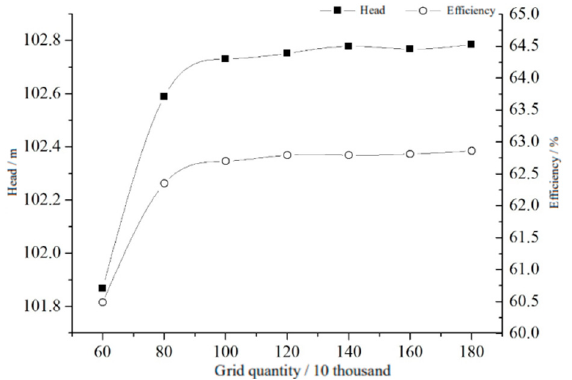
Figure 4. Effect of the grid number on the numerical simulation results.